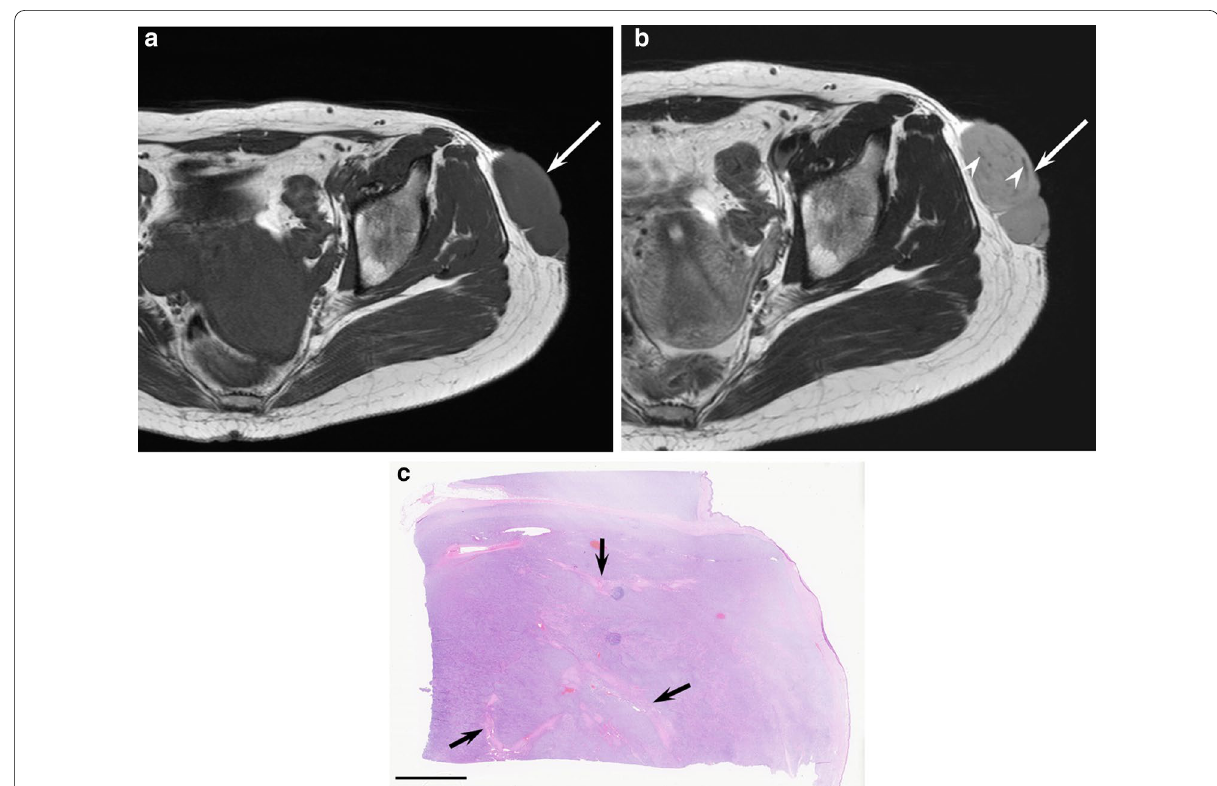
Fig. 12 A 27‑year‑old female with dermatofibrosarcoma protuberans on the hip. a Axial T1‑weighted image showing a subcutaneous mass (arrow). b Axial T2‑weighted image showing a hyperintense mass (arrow) with linear hypointensity (arrowheads). c Histological specimen (H&E stain; scale bar, 5 mm) showing tumor nests with fibrous tissue in the dermis (arrows)